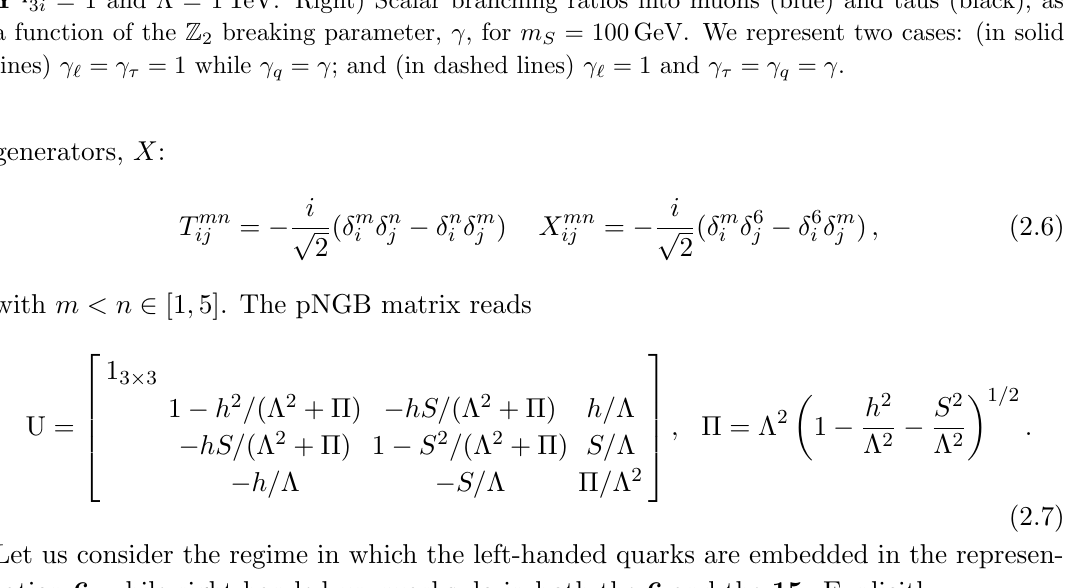
= e Y q = Y q i 3 = i 3 3 i